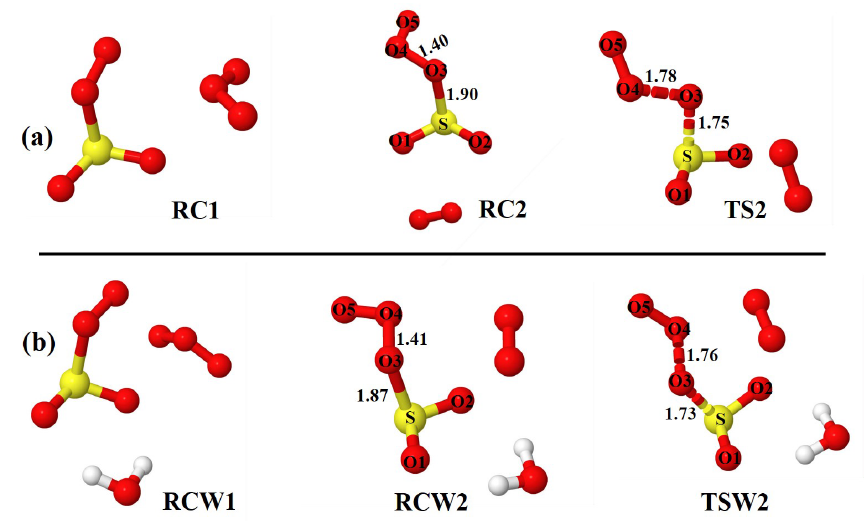
Figure 1. Optimized structures of the most stable intermediates in the O 2 SOO − + O 3 reaction (a) in the absence and (b) in the presence of a single water molecule. Optimizations were performed at the UM06-2X/aug-cc-pVTZ level of theory. Lengths (in Å) of some descriptive bonds are indicated. The color coding is yellow for sulfur, red for oxygen, and white for